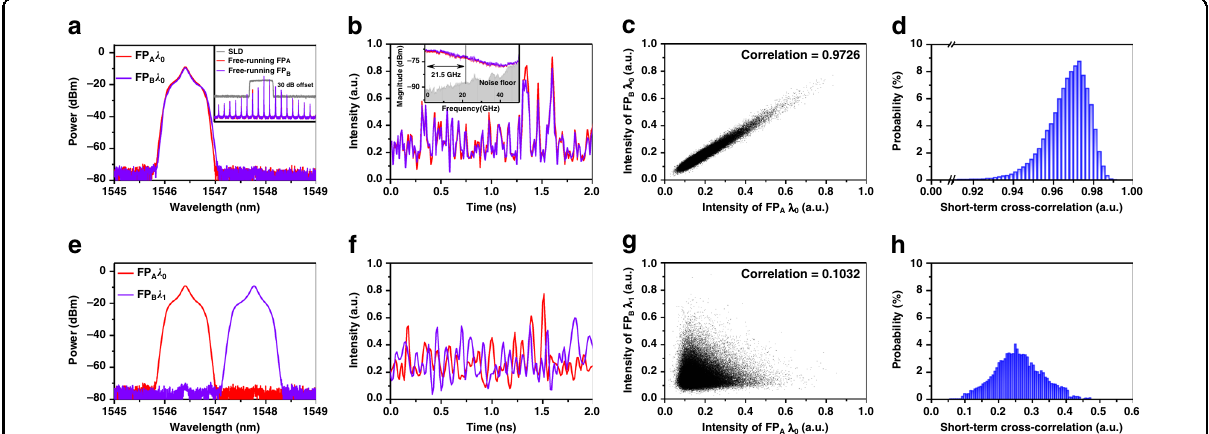
Fig. 2 Chaos synchronization of single longitudinal modes between FP lasers. a – d The same mode λ 0 = 1546.408nm, e – h different modes λ 0 and λ 1 = 1547.768 nm: optical spectra, temporal waveforms, scatter plot, and histogram of short-term cross-correlation. Bias currents I A = 11.2 mA, I B = 11.0 mA and injection power P j A = P j B = 400 μ W. The inset of Fig. 2b shows the electrical spectrum of chaotic light which indicates a bandwidth of 21.5